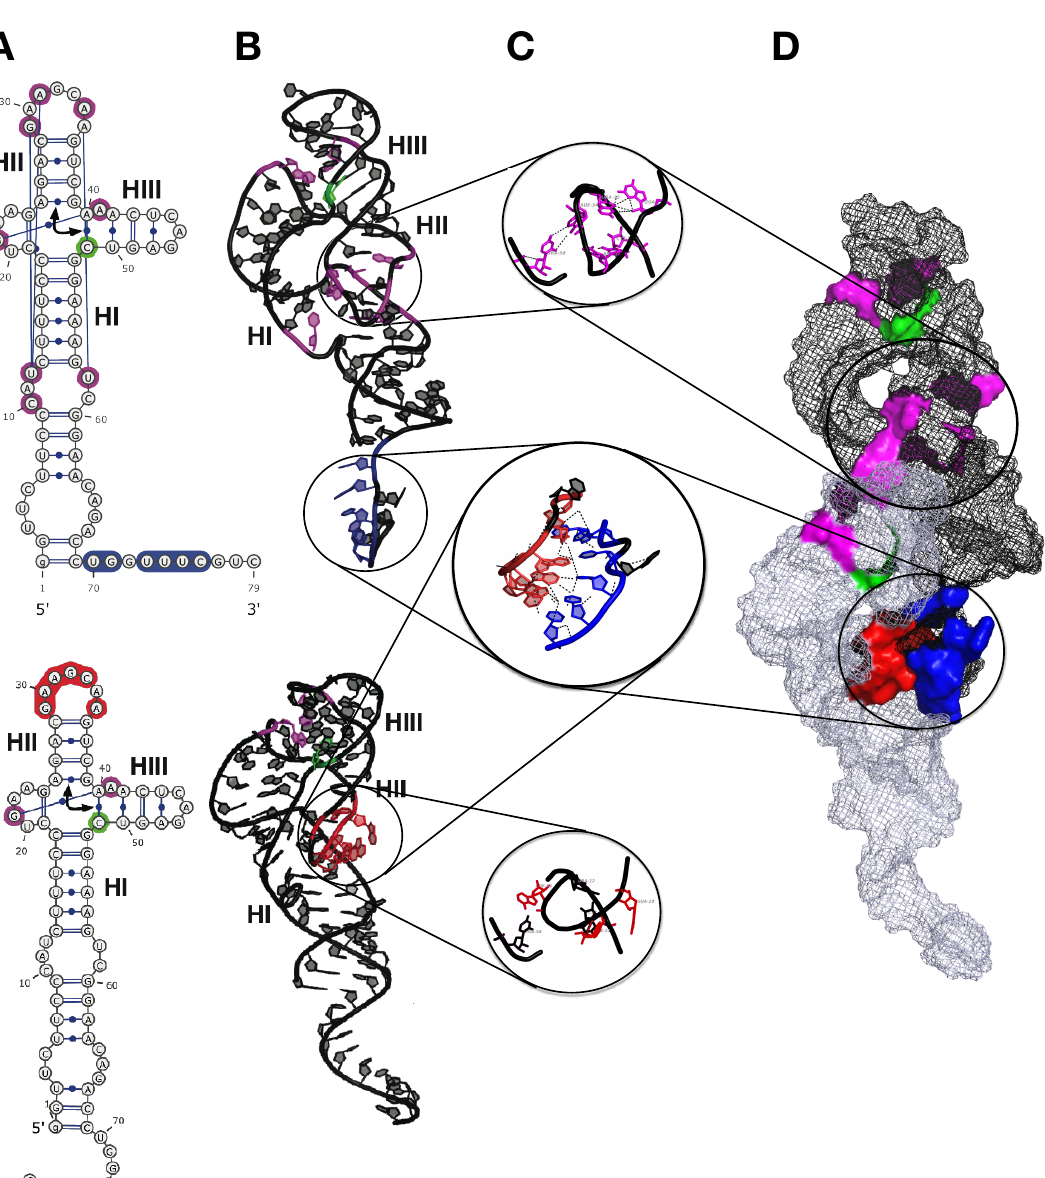
Figure 4. 3D Model of self-association for the hammerhead ribozyme (HHR) from ASBVd( − ). ( A ) 2D structures of the two monomers as they are in the HHR dimer. ( B ) 3D structures of the two monomers as they are in the HHR dimer. ( C ) Zoom in on the regions involved in the monomer-monomer interactions and in the 3D contacts within the first monomer (top). ( D ) 3D structure of the HHR dimer. The long-range intramolecular contacts are indicated in magenta and the cleavage site in green. The paired regions are blue (first monomer) and red (second monomer). Modified from Leclerc et al.